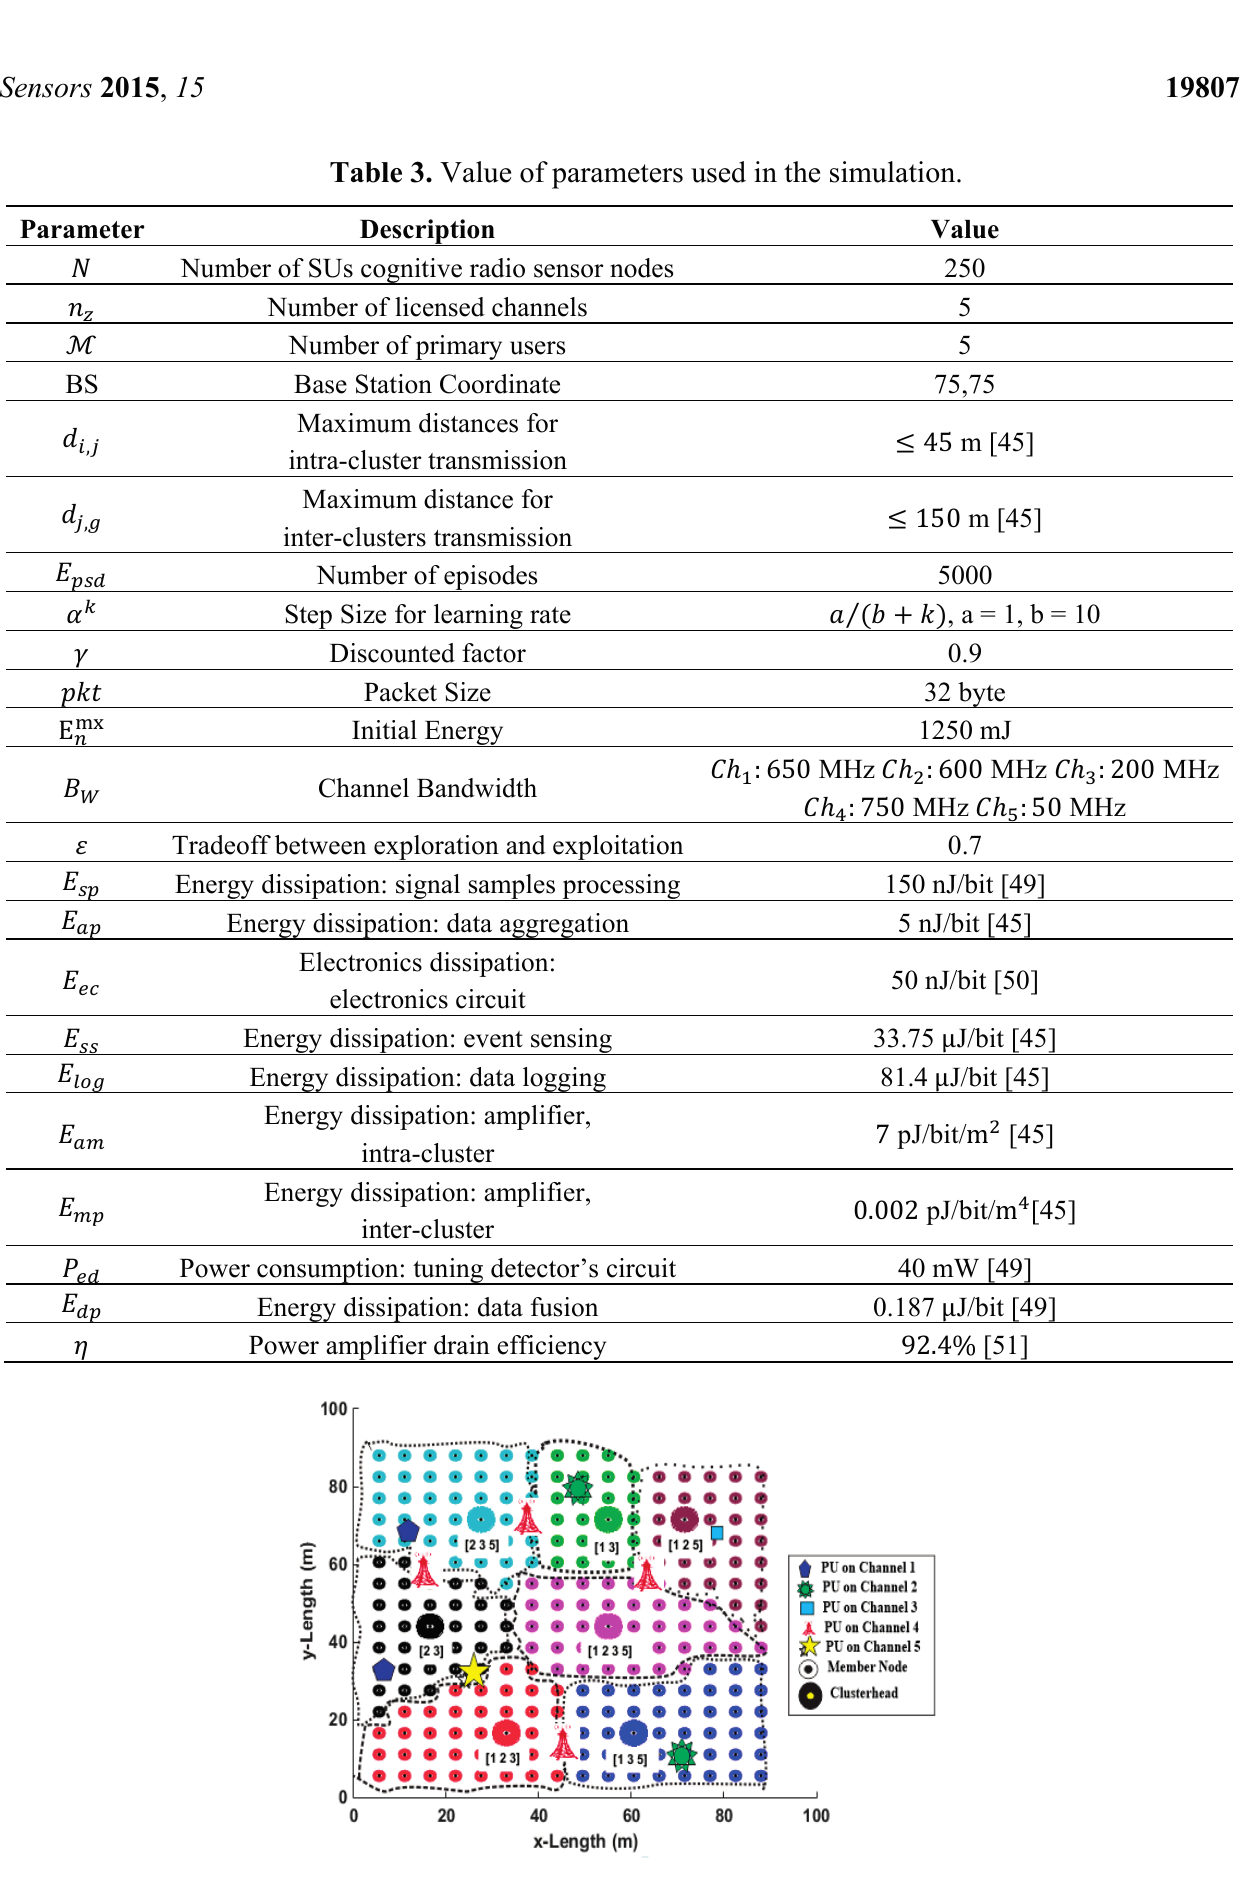
Figure 6. Pairwise spectrum-aware clustering